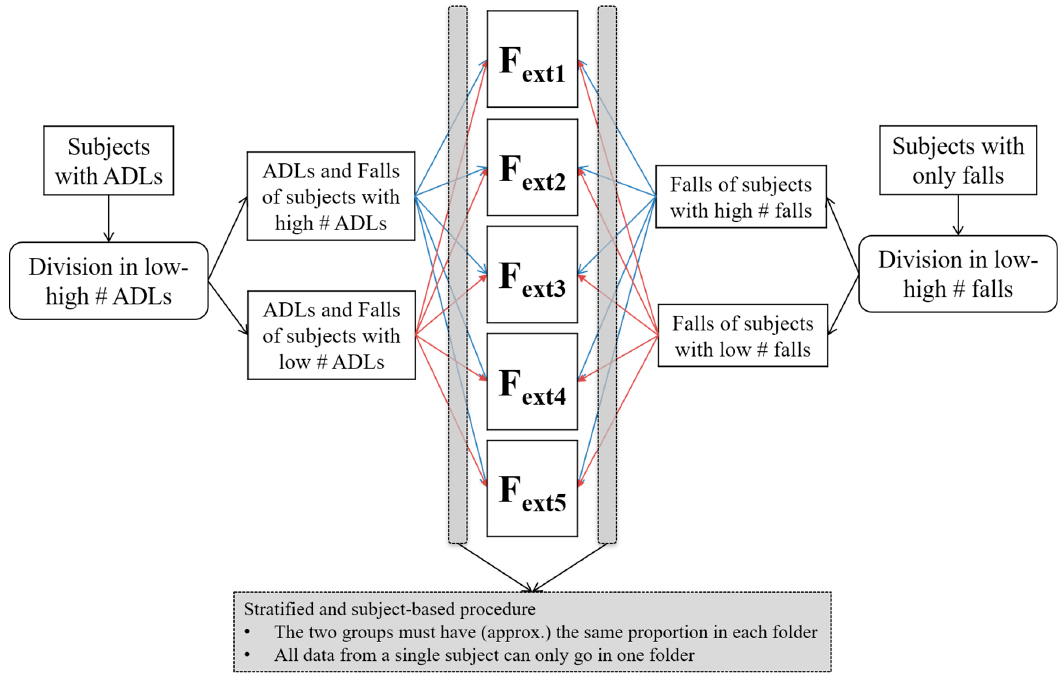
Figure 2. The stratification procedure for the five-fold cross-validation. The suffix “ext” for folds F reflects the fact that this cross-validation for performance evaluation was, in the case of the support vector machine (SVM) classifier, external with respect to internal cross-validation for model parameter selection (see Figure 3).